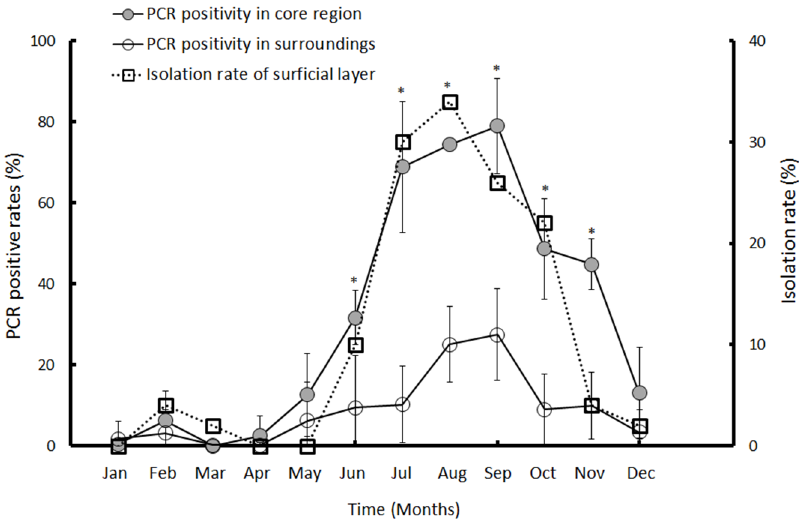
Fig 3. PCR positivity rates and the correlation between PCR positivity and the B . pseudomallei isolation rate. Air particles were collected from different sites (See Fig 1). The average PCR positivity rates per month at Sites D-G (core region, black circle) and Sites A-C and H-L (surroundings, hollow circle) are shown. The significant difference ( * , p < 0.05) of monthly PCR positivity between the core region and surroundings is shown. The isolation rates of B . pseudomallei (hollow square) in the superficial layer of a northwestern cropped field are shown.